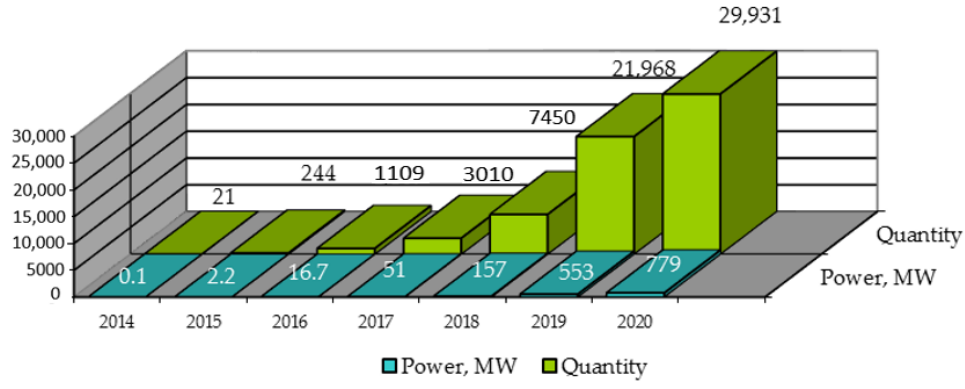
Figure 3. Dynamics of increate in the number and power of solar electrical installations in households in Ukraine 2014 – 2020 [24].